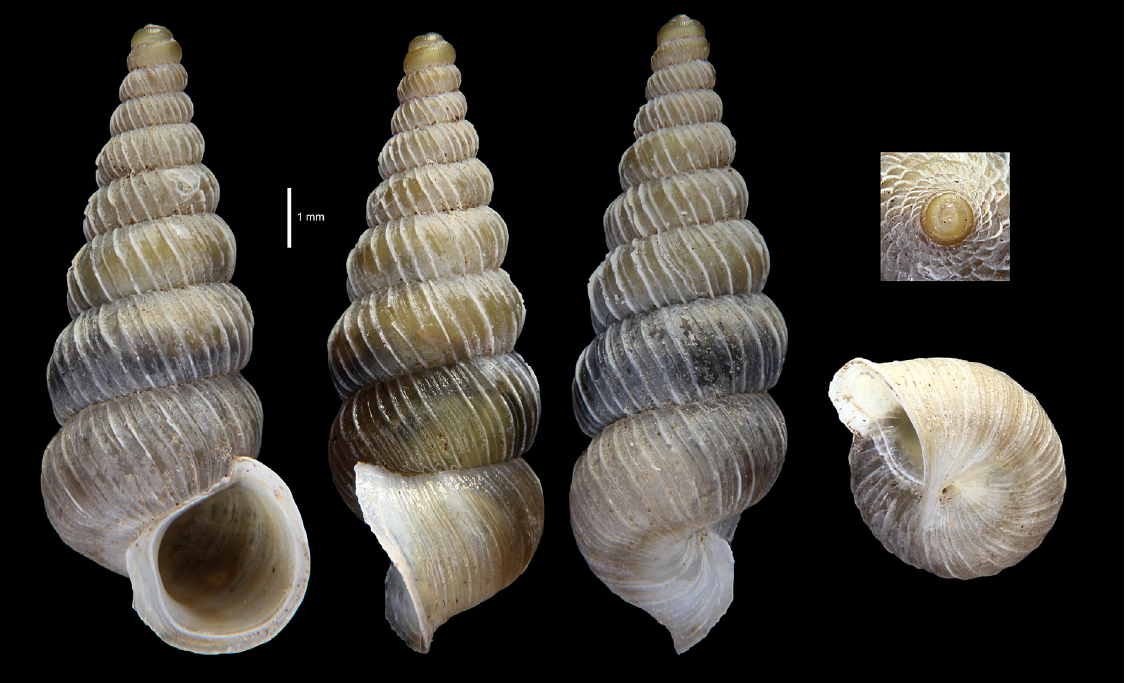
Fig. 12. Cochlostoma (Lovcenia) lanatum Zallot, Fehér & Gittenberger sp. nov., holotype, Deleve Cave, Albania (HNHM